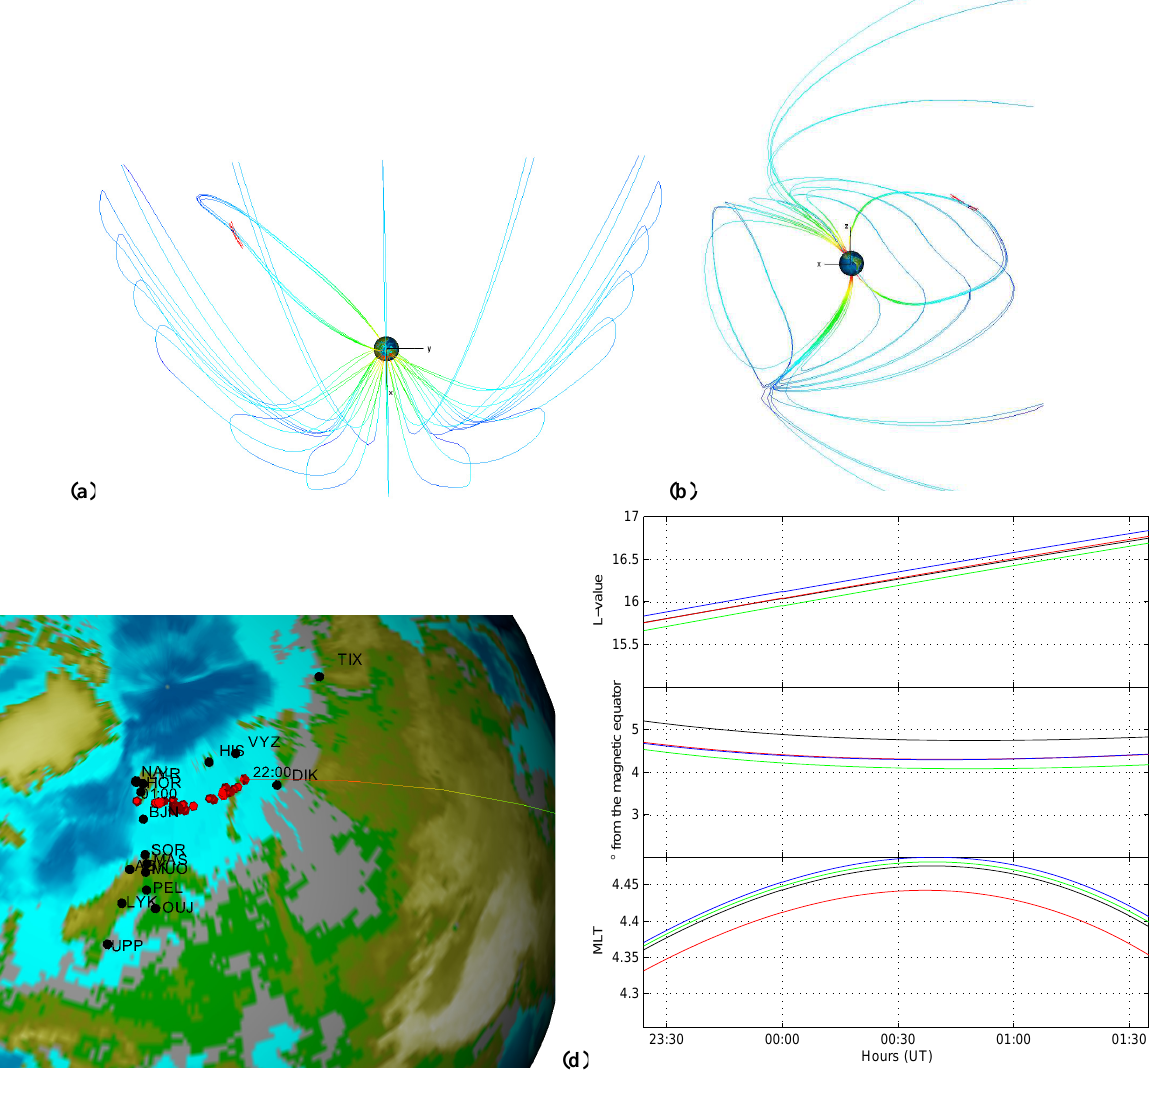
Fig. 1. Sketch of the magnetosphere at 00:00UT from the T01 model, the field lines which the Cluster satellites are located and the Cluster orbits (red lines) in GSM coordinates. (a) Projection in the GSM xy-plane. (b) Projection in the xz-plane. (c) Magnetic footprint for s/c 3 (red circles). Ground-based magnetometers are indicated by black circles. (d) Clusters position with respect to L-value (calculated from the IGFR model), angle from the dipole magnetic equator and magnetic local time (MLT).